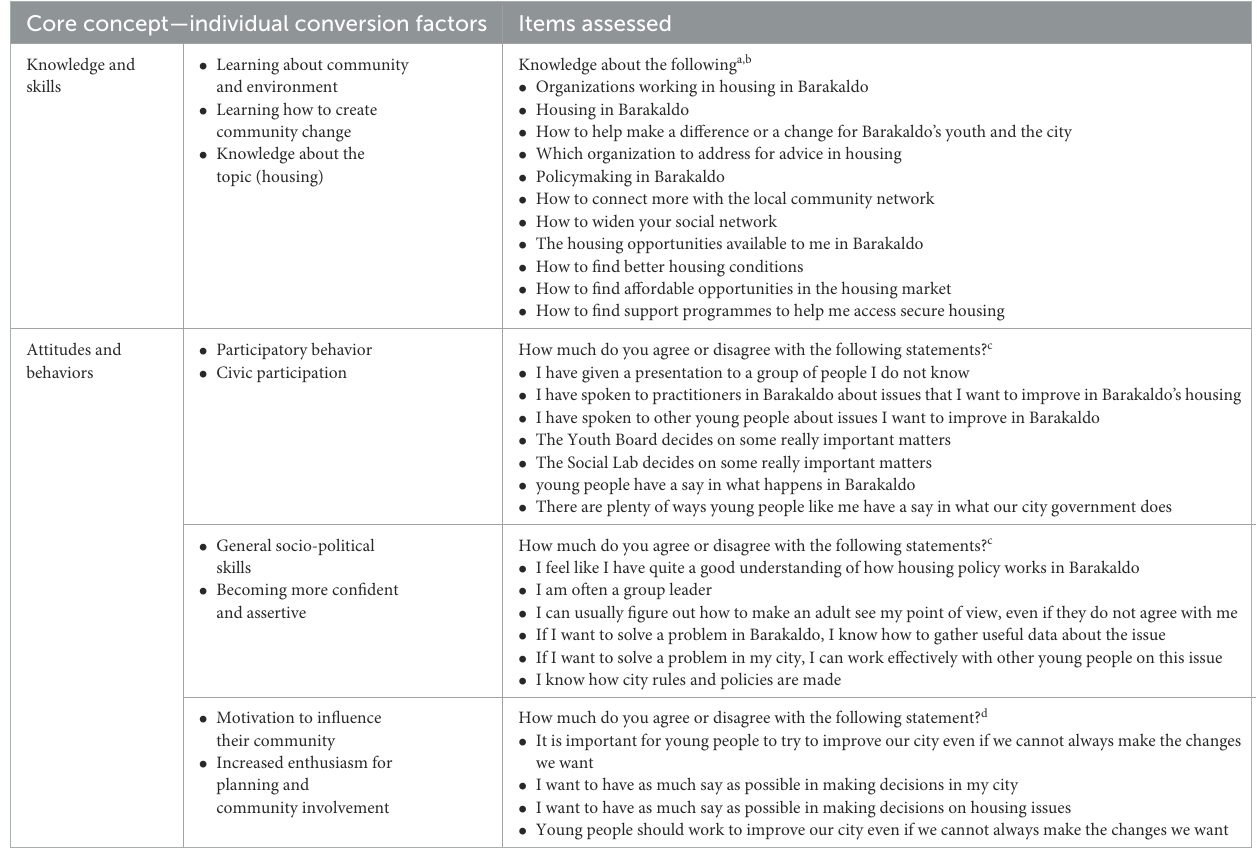
TABLE 2 Individual conversion factors